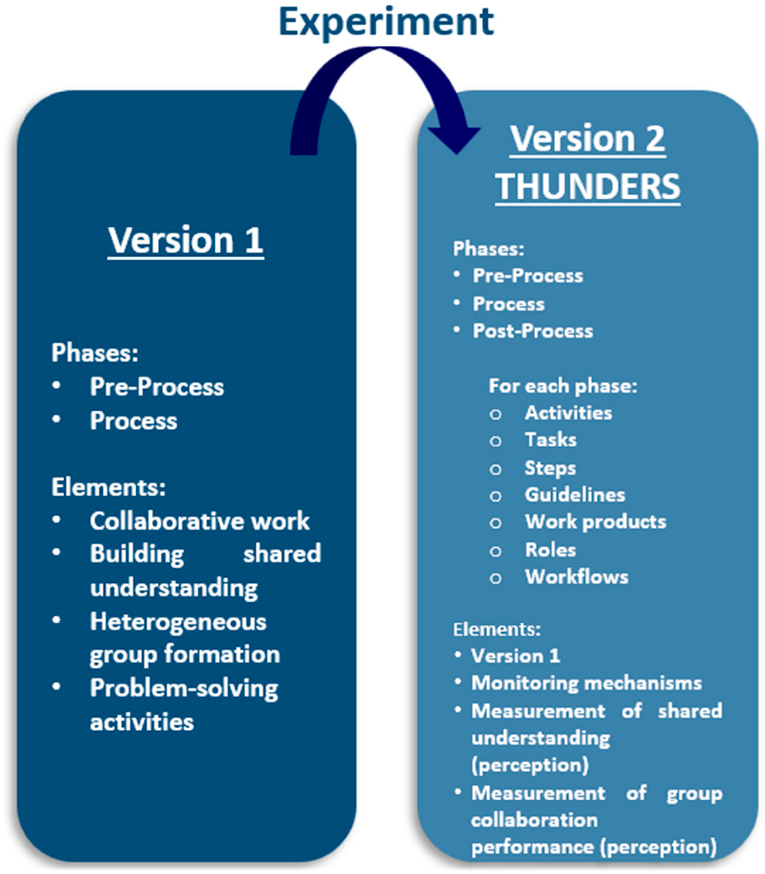
Figure 1. Differences between process versions .